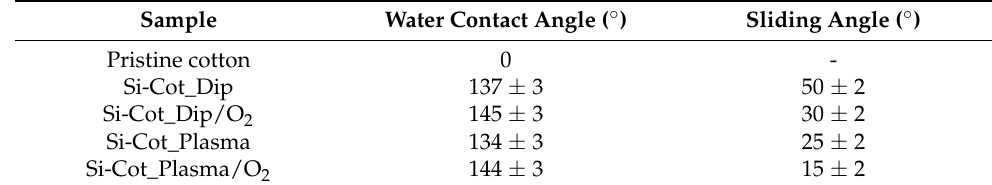
Figure 5. Water and oil on the surface of ( a ) Si-Cot_Dip/O 2 , ( b ) Si-Cot_Plasma/O 2 . Table 1. WCA and Sliding angle measurements for pristine cotton and Si-coating samples. Sample Water Contact Angle ( ◦